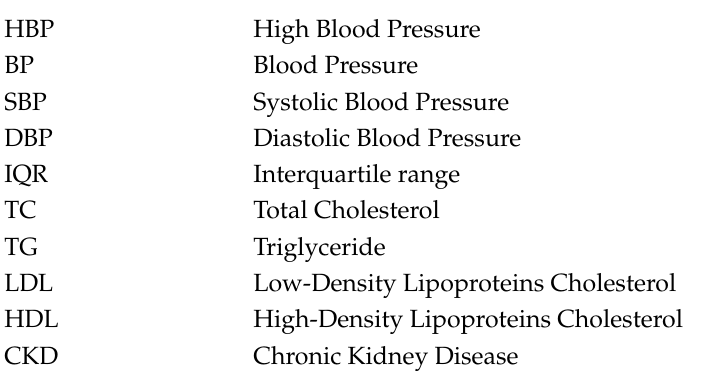
Figure S1: Flow chart of Data Management, Figure S2: Crude prevalence of hypertension by Ethnicity, Sex, and Age, Table S1: Crude rates of prevalence, awareness, treatment, and control by Ethnicity, Sex, and Age, Table S2: Age-, sex-adjusted rates of prevalence, awareness, treatment, and control between Ethnic